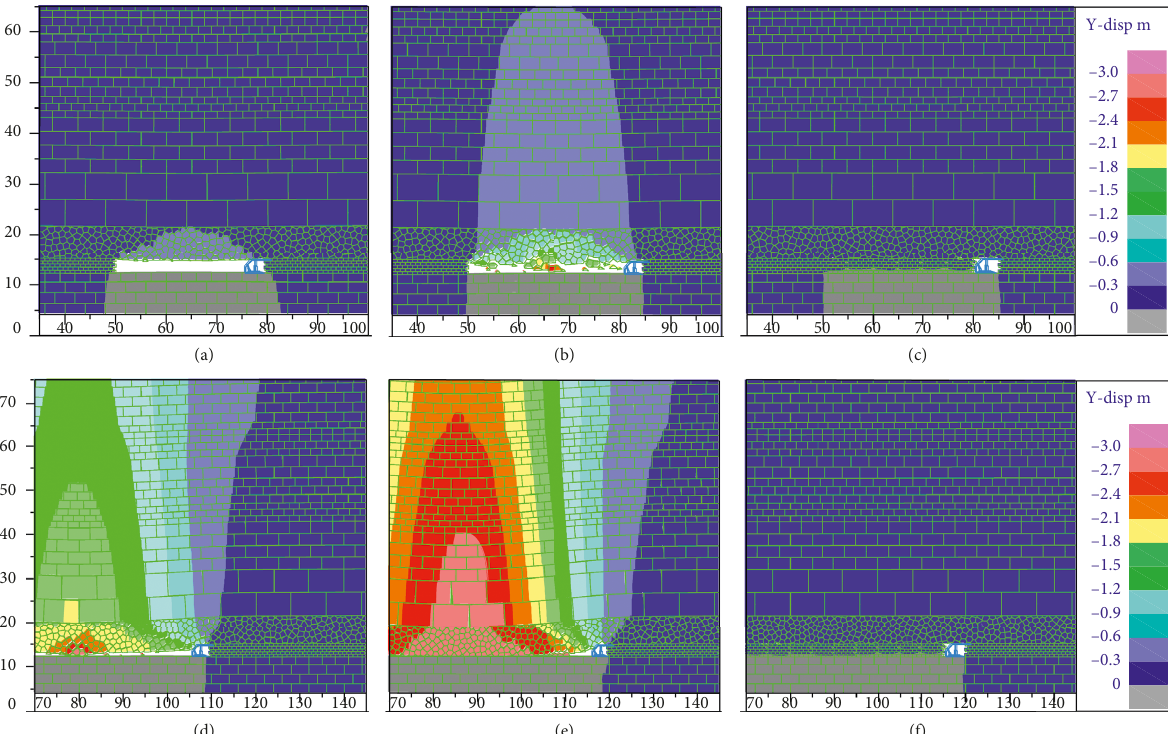
Figure 4: Vertical displacements of overlying strata in different roof management methods. (a) Nonbackfilling excavation 30m. (b) Nonbackfilling excavation 35 m. (c) Backfilling excavation 35m. (d) Nonbackfilling excavation 60m. (e) Nonbackfilling excavation 70m. (f) Backfilling excavation